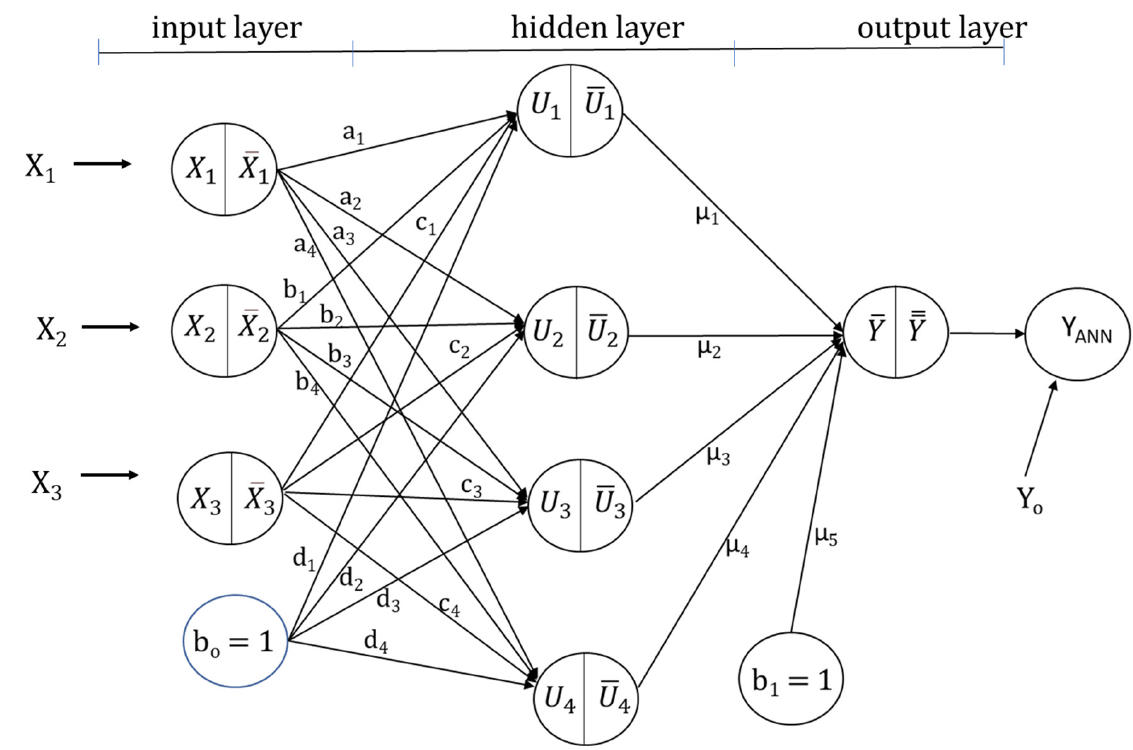
Figure 1. Configuration of an ANN model for estimating settling velocity. Table 2. Input and output parameters for ANN1 to